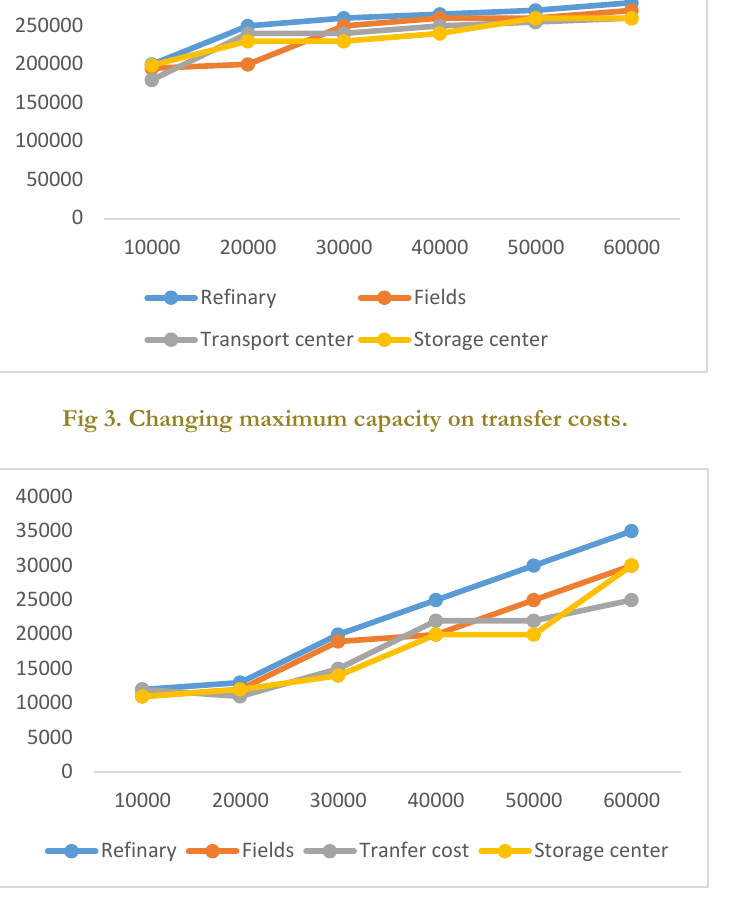
Fig 4. Changing maximum capacity on inventory costs.